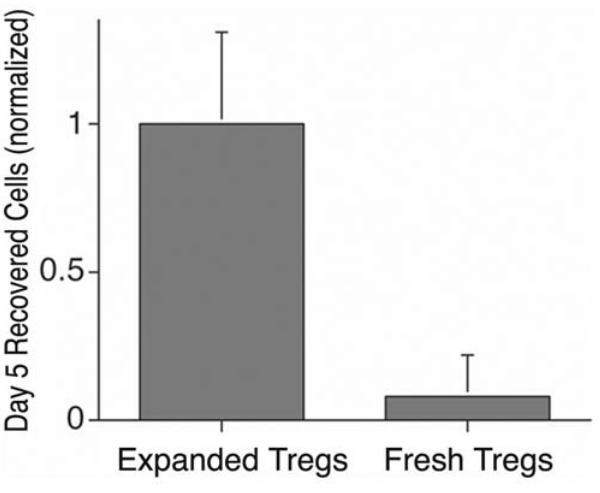
Figure 3. Enhanced in vivo survival of expanded T regs as compared to freshly isolated T regs following adoptively transfer. Bar graph demonstrates that the number of exogenously expanded CFSE + CD4 + Foxp3 + T regs recovered from lymphatic and solid organs 5 days after adoptive transfer (adjusted for the variability in total cell recovery from each recipient mouse) is significantly greater than that for freshly isolated and adoptively transferred T regs (p , 0.01, 3 mice per